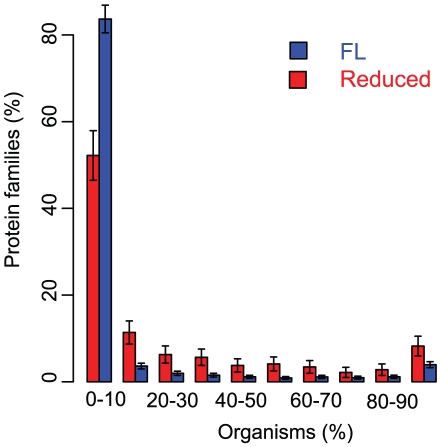
Conservation of protein families by fraction of the organisms.Only a restricted core of families is present in the majority of organisms in both Reduced and FL. The two distributions are significantly different at p<2.2×10−16 (χ2 homogeneity test).